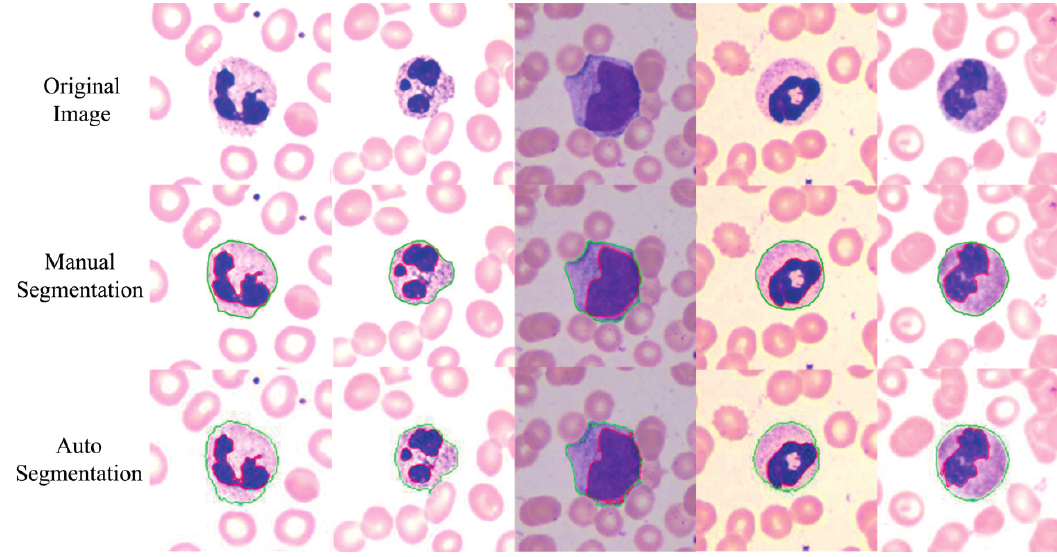
Figure 14. Comparison of the proposed method and the manual method on single WBC segmentation.